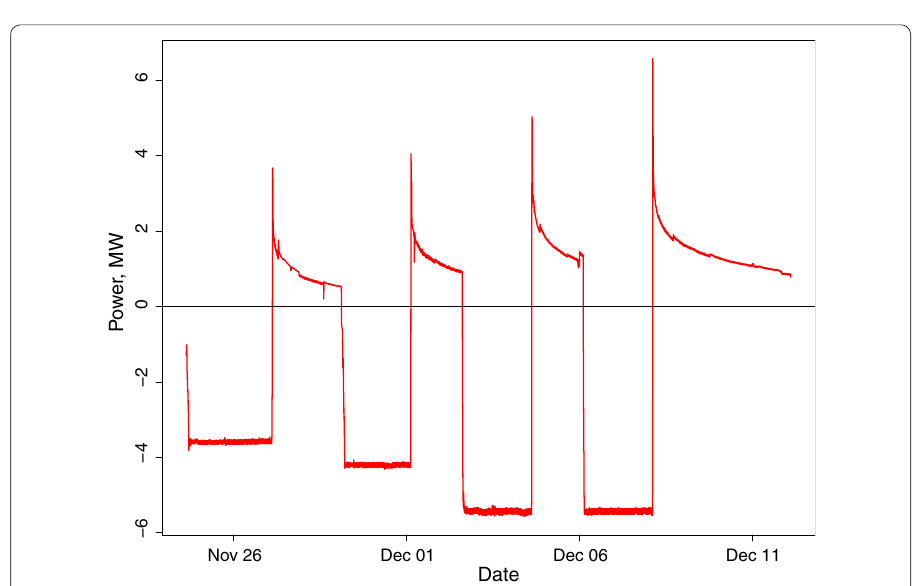
Fig. 12 Comparison of injected and recovered power during the heat storage